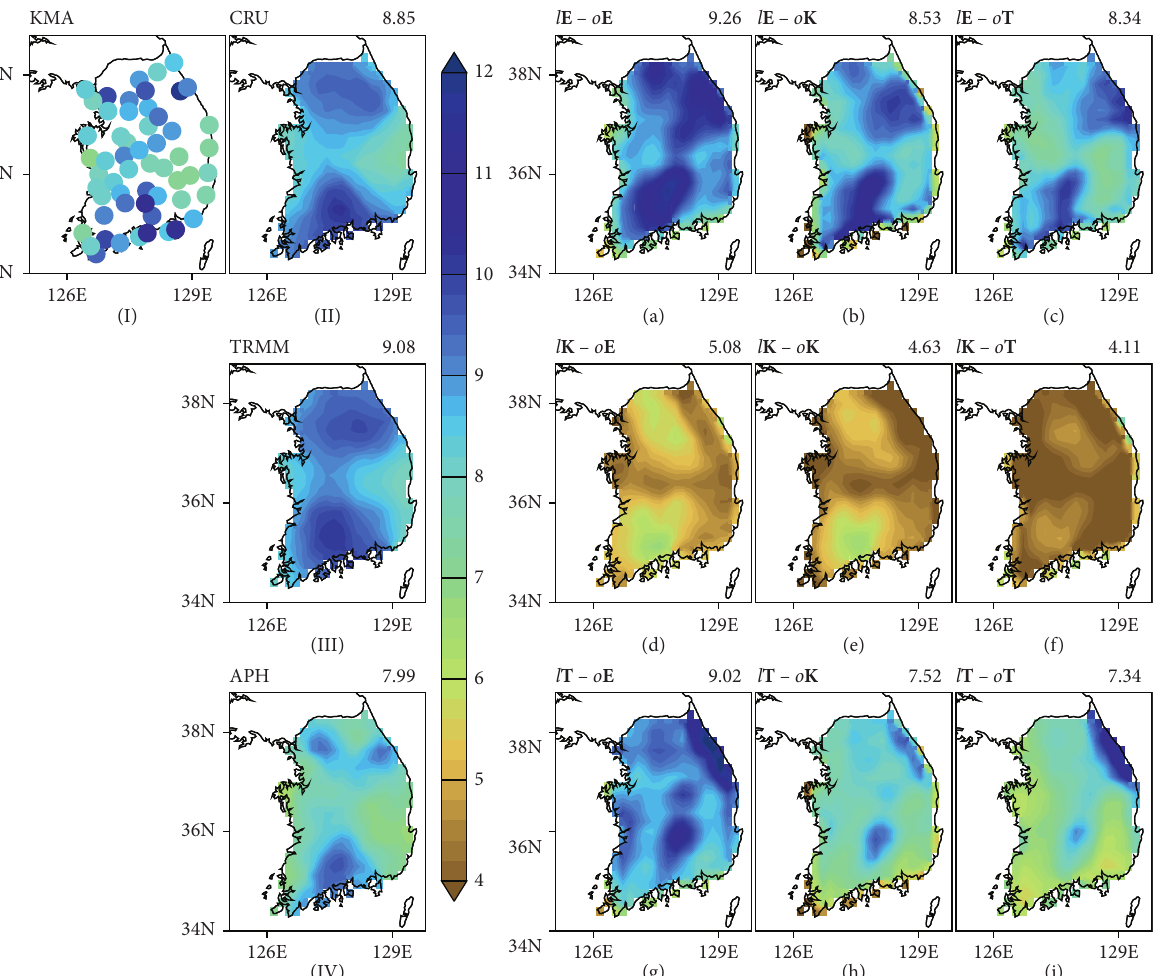
Figure 3: Spatial distribution of JJAS climatological mean precipitation (1998–2007, mm/day) derived from (I)–(IV) multiple observations and (a)–(i) model simulations. The number at the top-right of each panel is the mean precipitation area-averaged over South Korea